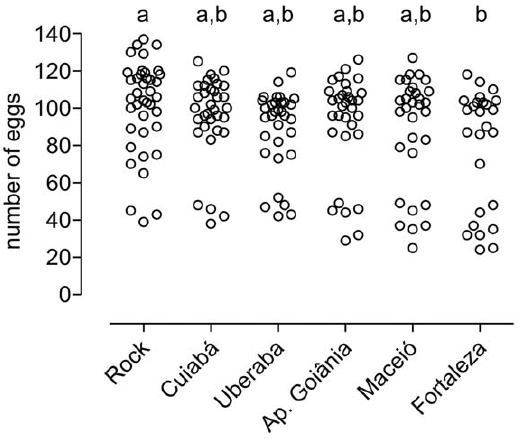
Figure 8. Number of eggs – field populations. Number of eggs per egglaying female of Aedes aegypti F1 field population and Rockefeller. Each dot indicates the number of eggs from an individual female. Identical letters above the scatter dots mean non-significant differences according to One Way ANOVA followed by Tukey Multiple Comparison